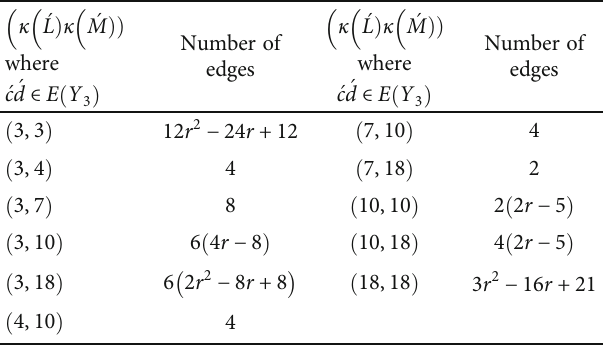
Table 3: The edge partition of fourth type of rectangular hex- derived